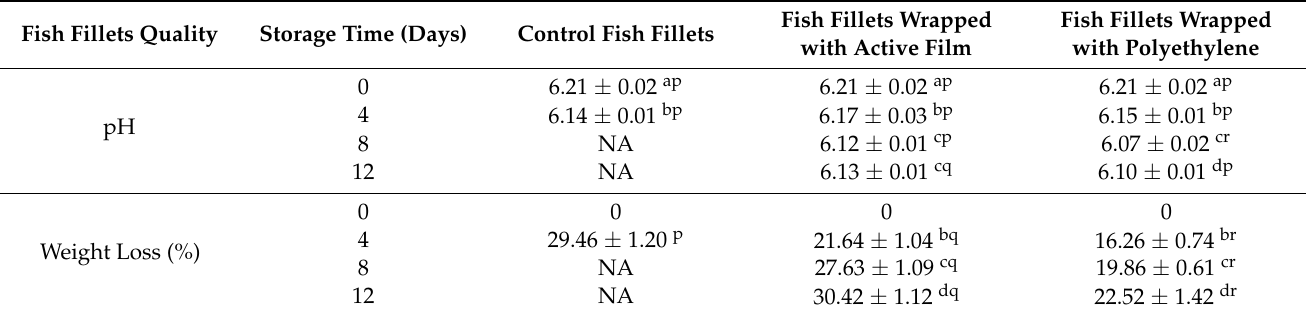
Table 2. Change in pH and weight loss of fish fillets qualities during storage.